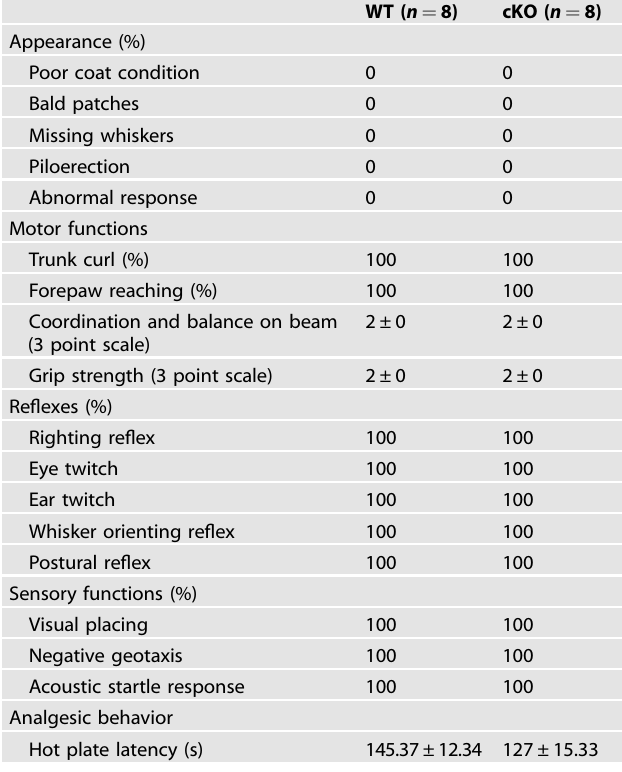
Table 1. General health assessment of cKO